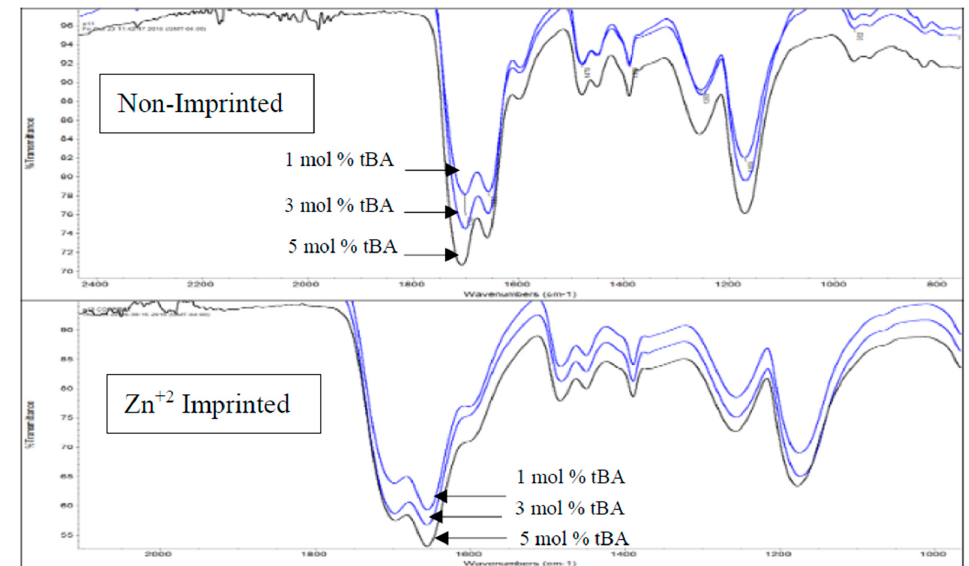
Figure 5. IR expansion of carboxylic acid and amide C=O region for variable tBA content. Spectra stacked in order of increasing tBA concentration with non-imprinted on top and imprinted on bottom.